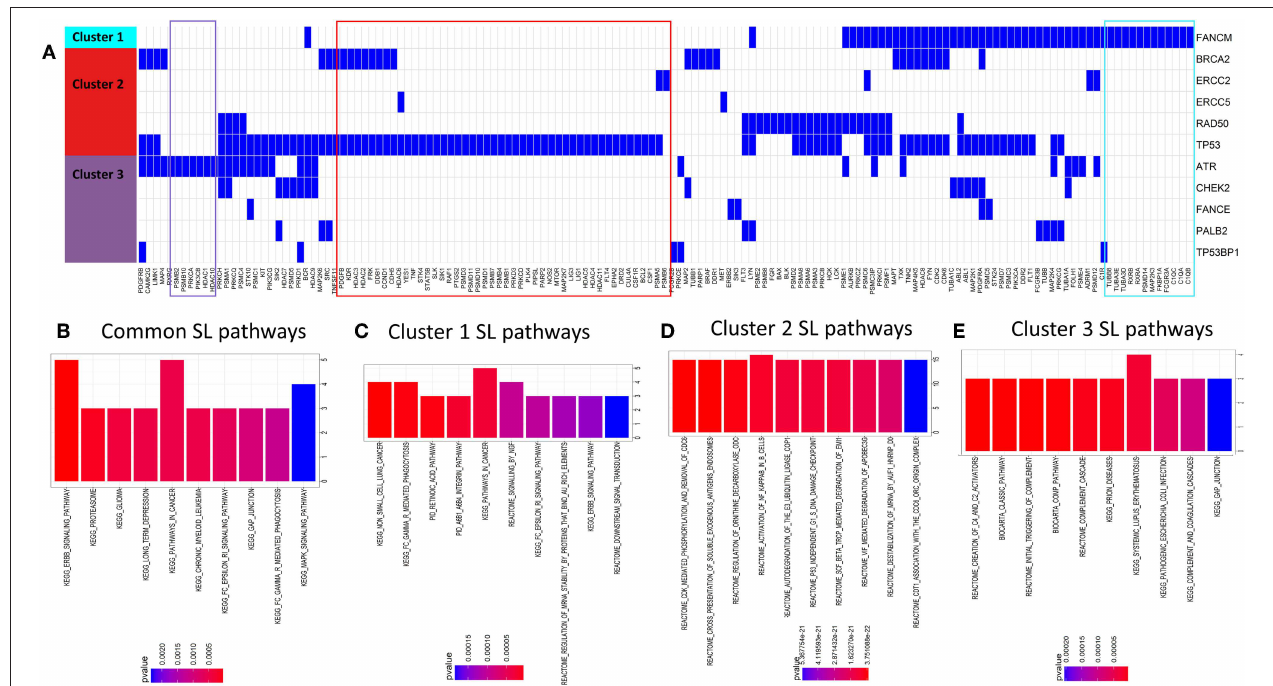
FIGURE 4 | (A) Predicted SL interactors of genes mutated in cluster 1, cluster 2, or cluster 3. Blue denotes an SL interaction and white denotes no SL interaction between the corresponding SL gene (columns) and DDR cluster (row). We can see there is some overlap and some exclusivity between SL partners for DDR genes from different DDR clusters. (B–E) Barcharts show pathways enriched for predicted synthetic lethal partners (B) common for all clusters (C–E) , unique for gene mutations specific to DDR clusters 1, 2 and 3,